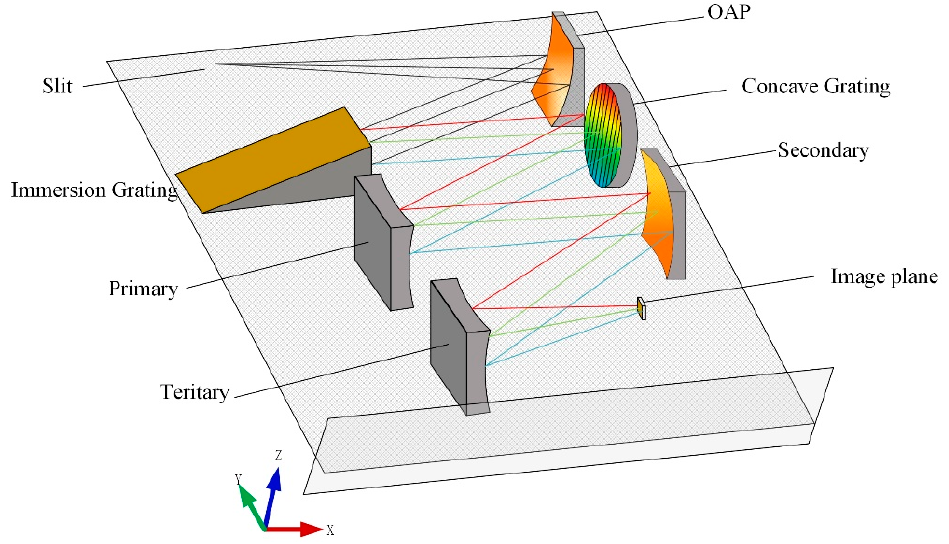
Figure 6. Basic optical path of the IESTMA system.